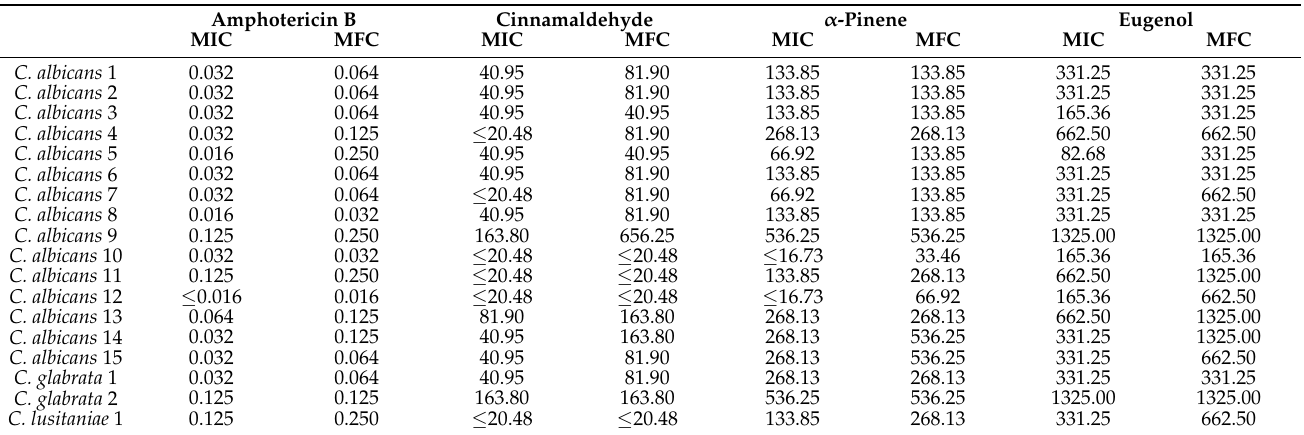
Table 4. Antifungal effects of selected natural compounds against Candida strains evaluated by mi- crodilution assay.